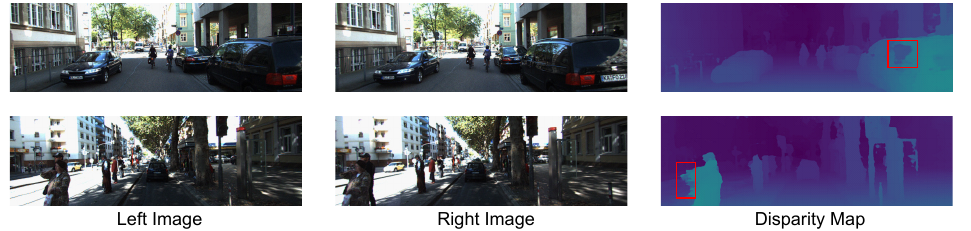
Figure 7. Failure examples. Our network still cannot deal with specular reflection and object occlusion